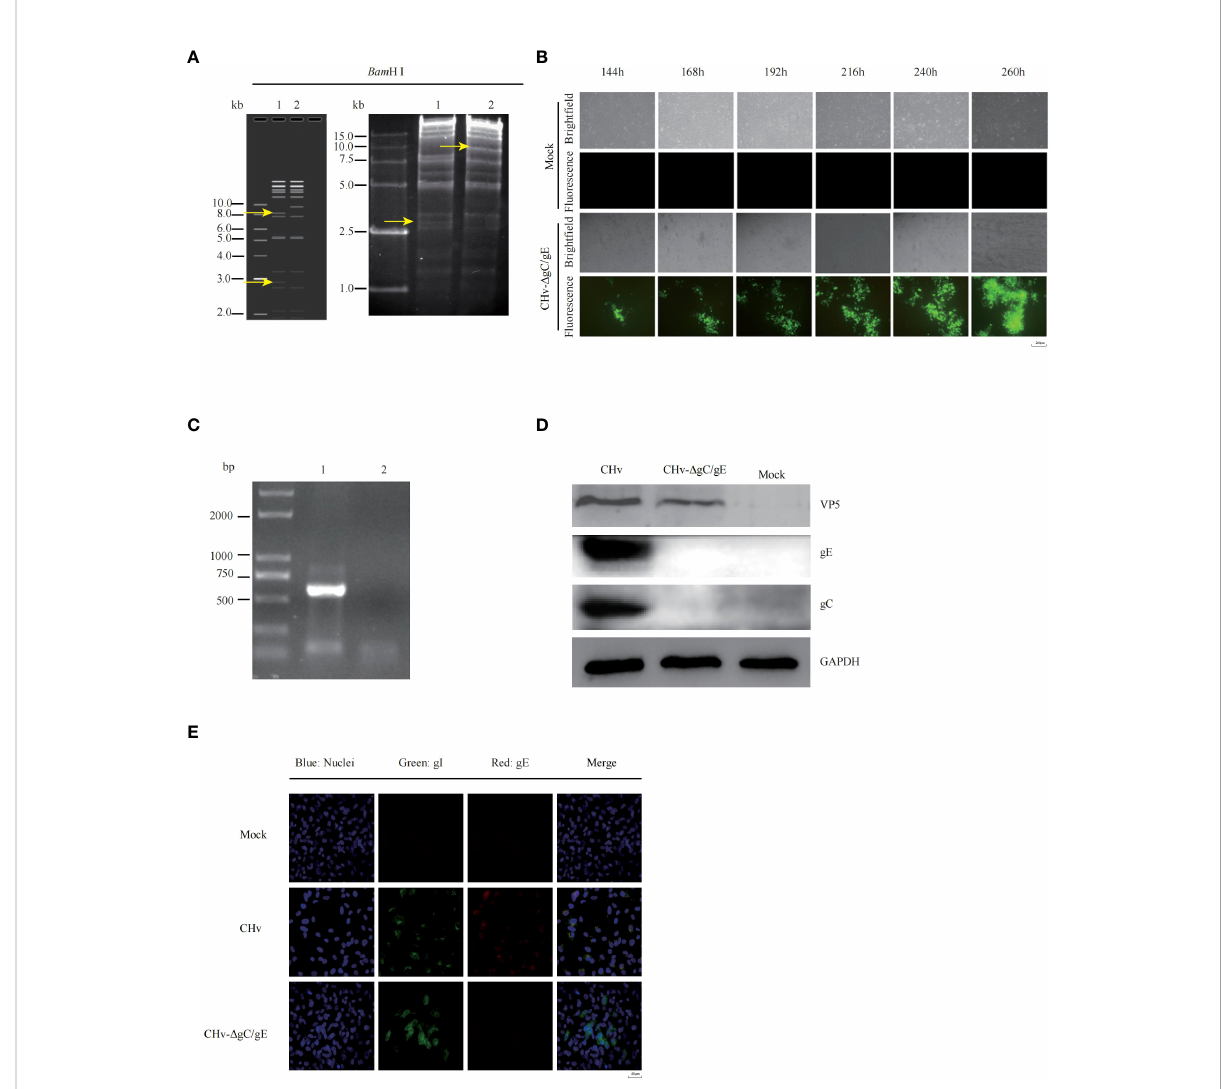
FIGURE 2 Generation and identi fi cation of recombinant CHv with deletion of gC/gE genes. (A) Predicted and actual RFLP analysis of CHv and CHv- D gC/gE infectious clones. The obtained DNA was digested with BamH1 and electrophoresed in a 0.7% agarose gel. (line 1:BAC-CHv, line 2: BAC-CHv- D gC/gE) (B) Transfection of the plasmids CHv- D gC/gE -GS1783 into DEFs resulted in numerous fl uorescent spots and cytopathies, the mutant virus CHv- D gC/gE were rescued. (C) PCR analysis of the gE expression of CHv- D gC/gE. (line 1: CHv- D gC/gE, line 2: Mock) (D) DEFs were infected (MOI = 0.01) with CHv- D gC/gE or CHv. At 24 h post infection (hpi), the levels of gC and gE proteins were determined with western blotting. (E) DEFs were infected (MOI = 0.1) with CHv- D gC/gE, CHv. Expression of gE and gI proteins was detected by indirect immuno fl uorescence at 36